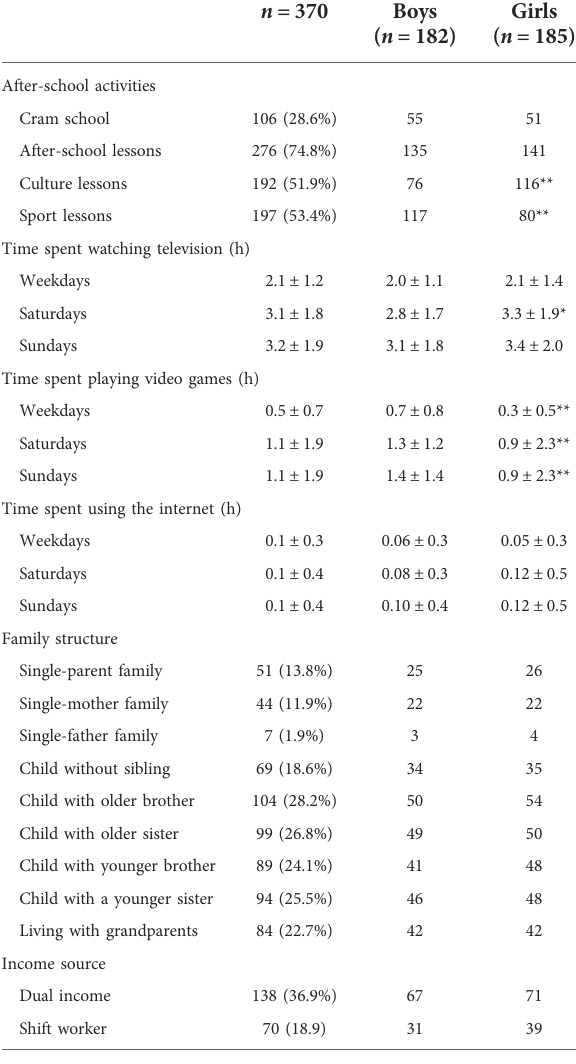
TABLE 2 Participants ’ extracurricular activities, family structure, and family employment status.